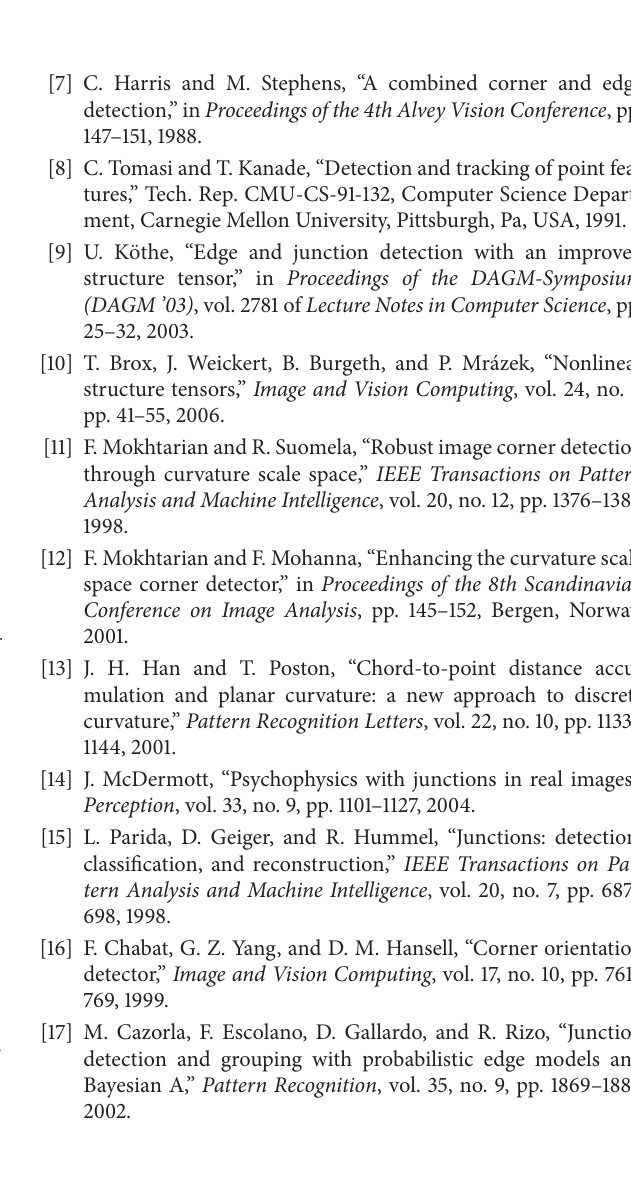
Figure 5: Comparison of the detection results for four SAR images [29]. (a) The detection results of the SAR image (size: 256 ∗ 256 ). Left: JUDOCA; right: proposed algorithm. (b) The detection results of the SAR image in the City of Maoming (size: 1358 ∗ 1036 ). Left: JUDOCA; right: proposed